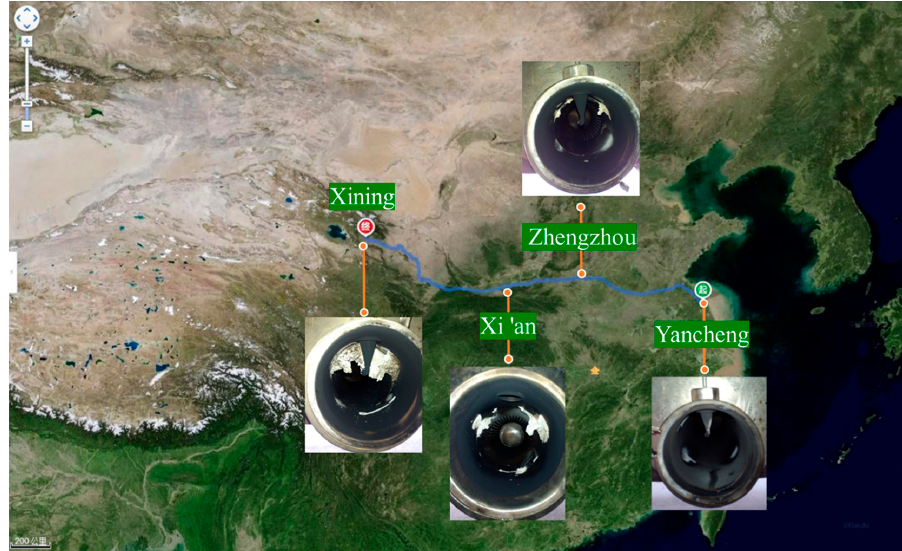
Figure 1. Deposits formation in the exhaust pipe during the vehicle’s operation equipped with SCR system. (Cities: Yancheng in Jiangsu Province, Zhengzhou in Henan Province, Xi’an in Shaanxi Province, and Xining in Qinghai Province)